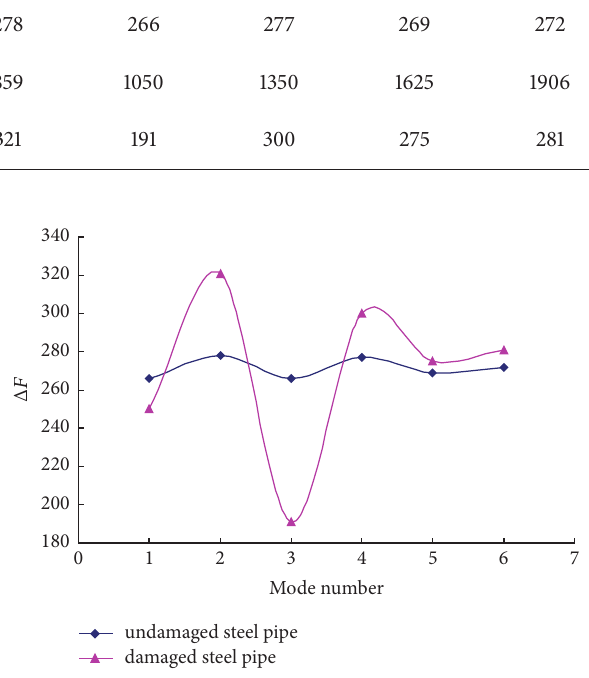
Figure 15: Neighbouring frequency interval of both